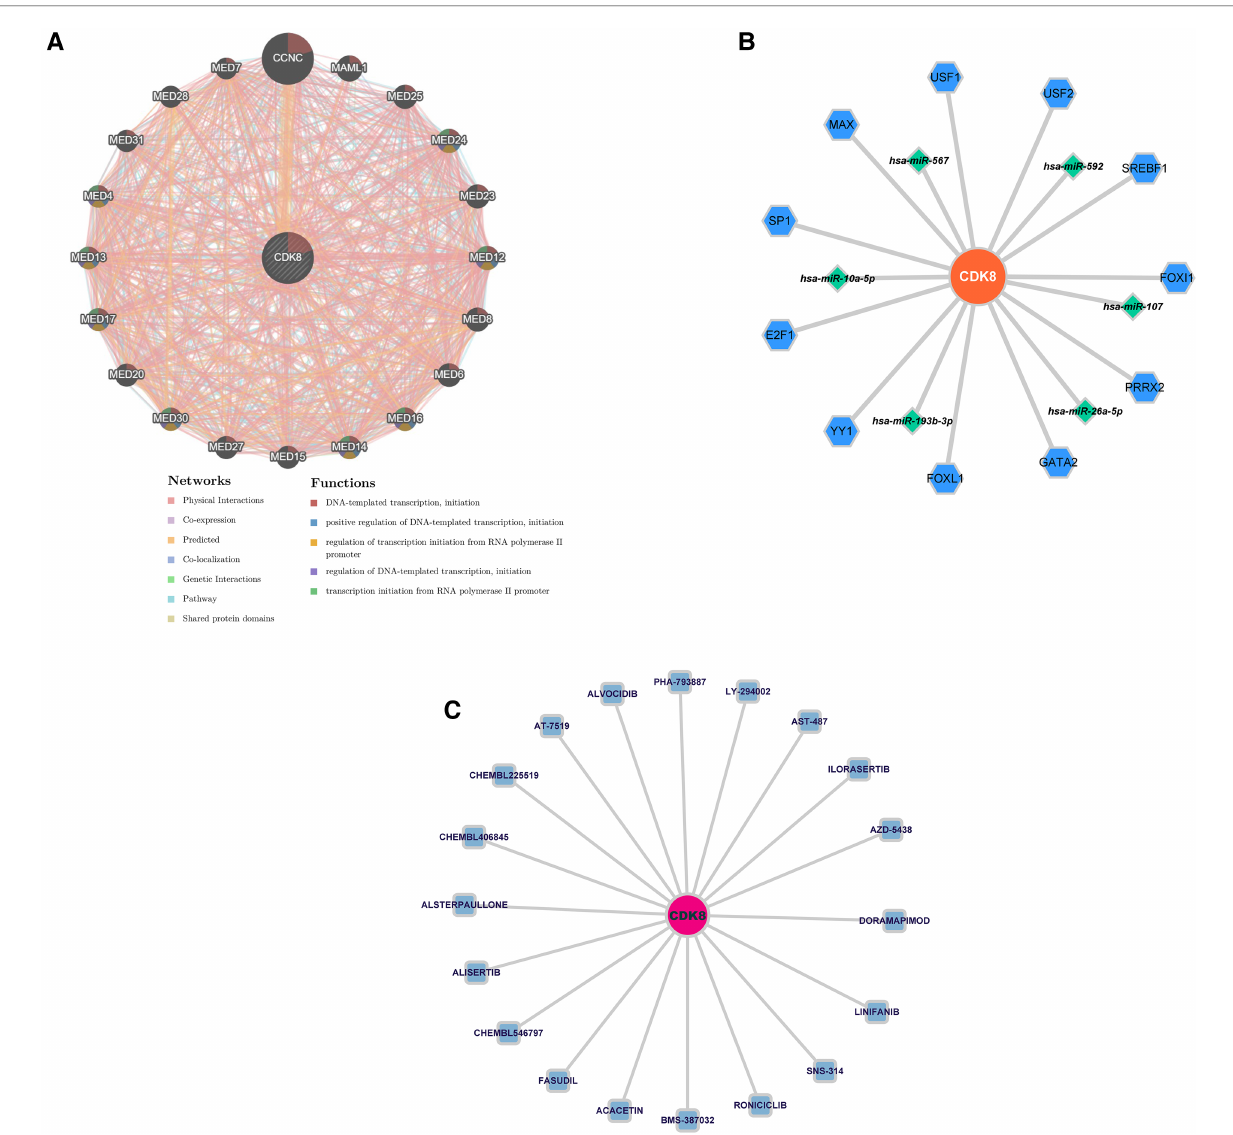
FIGURE 7 ( A ) Co-expression network of CDK8. ( B ) The “ TF-mRNA-miRNA ” regulatory network of CDK8. Blue hexagons are TFs; green diamonds are miRNAs. ( C ) Drug prediction for CDK8 based on DIGDB database. Blue squares are potential